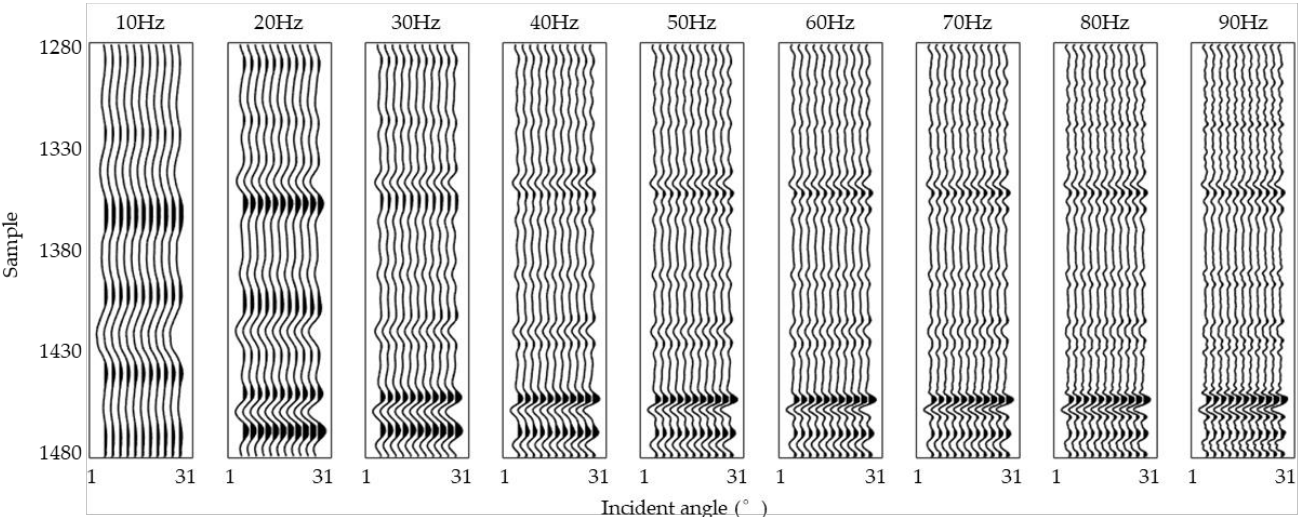
Energies 2021 , 14 , x FOR PEER REVIEW Figure 8. The synthetic seismic data for a set of frequency in small incident angles.